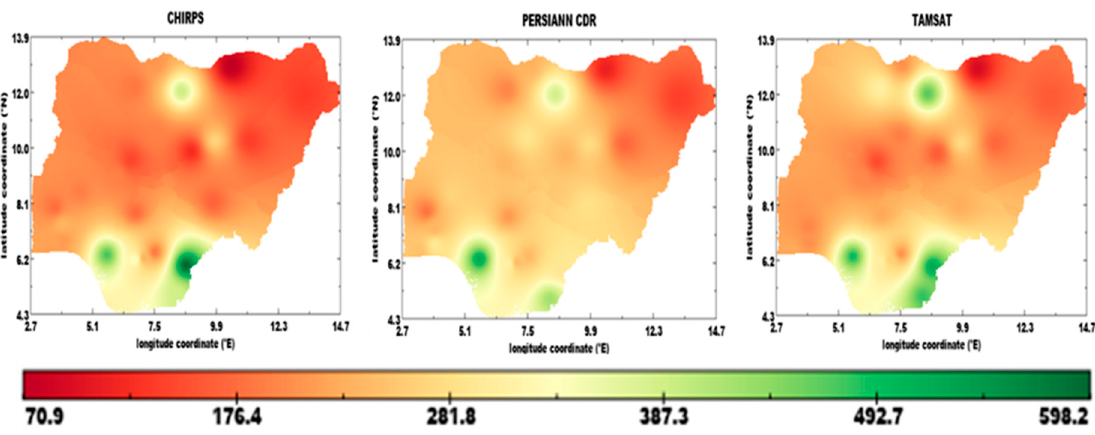
Figure 10. Percent bias ( PBIAS) of annual rainfall (mm/year)over Nigeria.